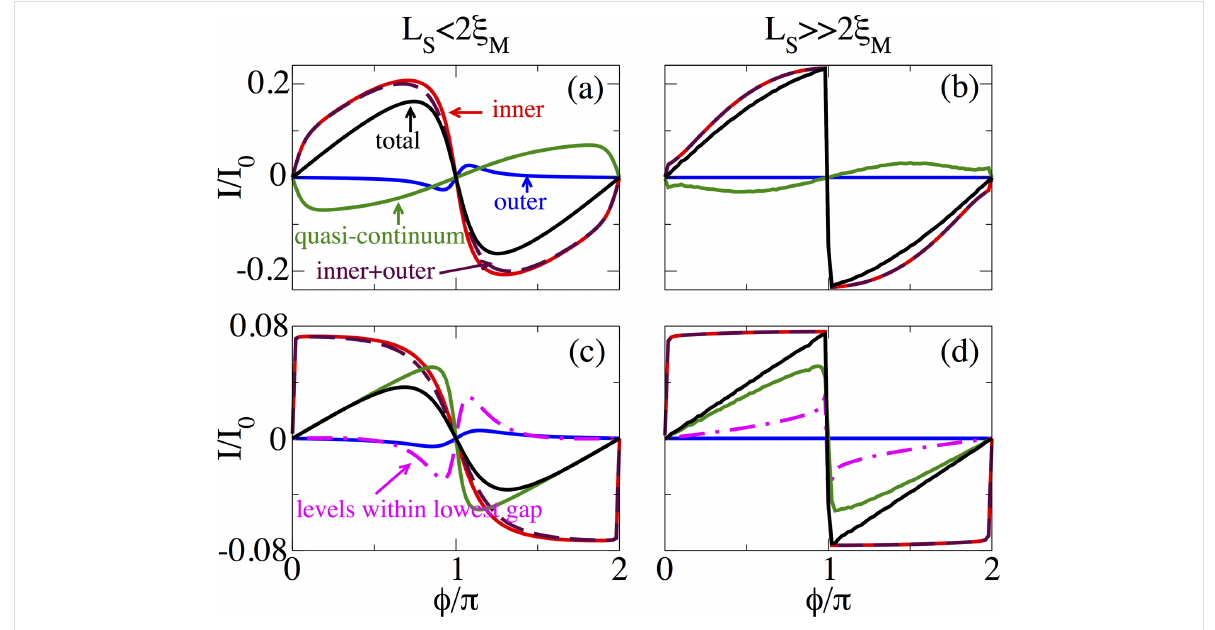
Figure 13: Supercurrent as a function of at B = 1.5 B c . Contributions to the supercurrent for (a,b) short and (c,d) long junctions. (a,c) L S ≤ 2 ξ M and (b,d) . The different curves in (a,b) correspond to individual contributions to I ( ) from outer, inner, and outer + inner (levels within the lowest induced gap Δ 2 ), quasi-continuum (levels above the lowest gap Δ 2 ) and total levels. In (c,d), the additional magenta curve corresponds to all levels within Δ 2 . In long junctions the number of levels within Δ 2 exceeds the number of MBSs. MBSs coexist with additional levels within Δ 2 . Parameters: α R = 20 meV·nm, μ = 0.5 meV, Δ = 0.25 meV and .